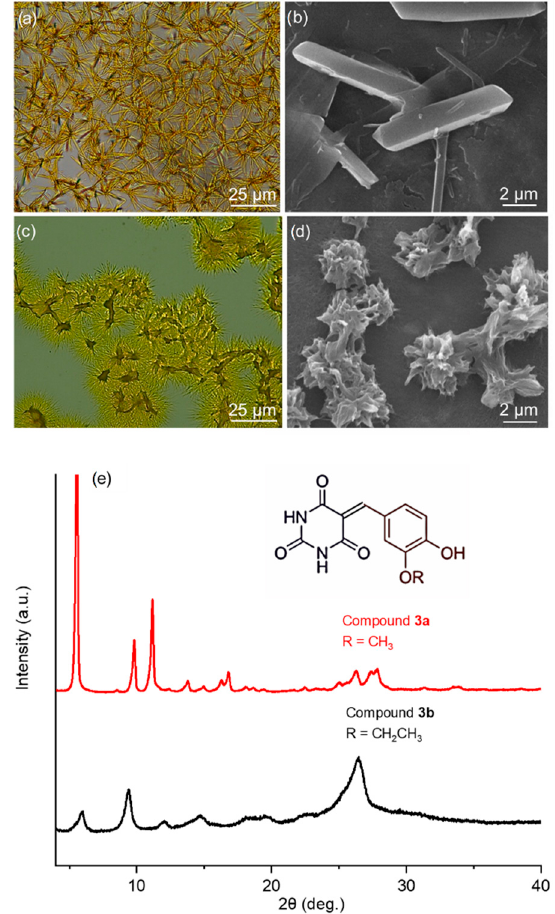
Figure 1. ( a , c ) Optical microscopy and ( b , d ) SEM images of compounds ( a , b ) 3a and ( c , d ) 3b and ( e ) their powder XRD patterns.